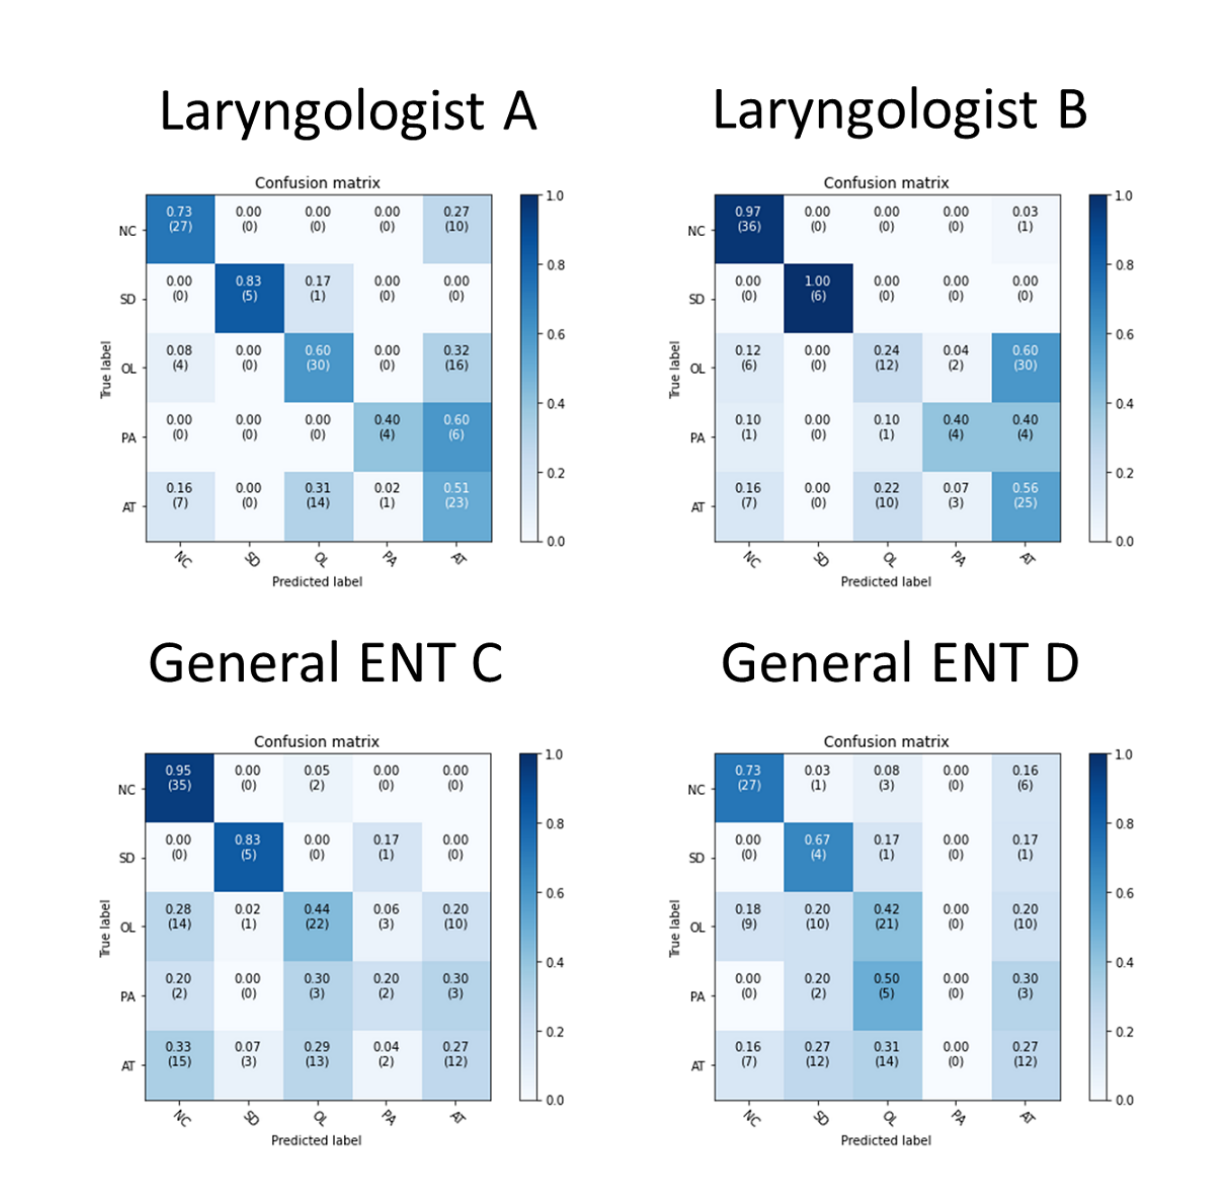
Figure 4. Confusion matrix of 5 classifications in human specialists. NC = normal voice; SD = adductor spasmodic dysphonia; OL = organic vocal fold lesions; PA = unilateral vocal paralysis; AT = vocal